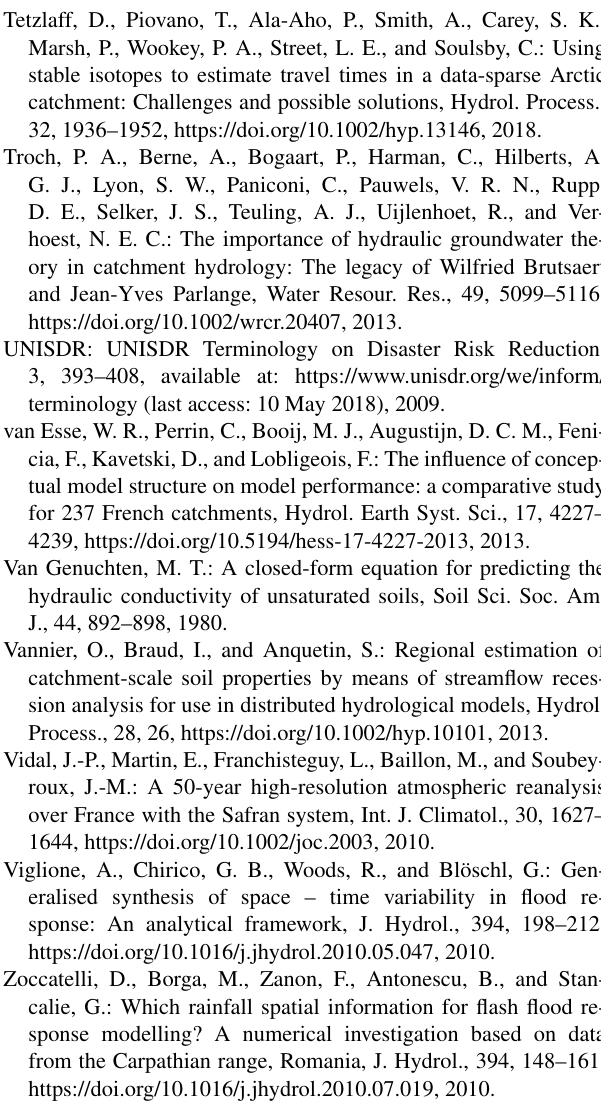
Tabary, P.: The new French operational radar rainfall